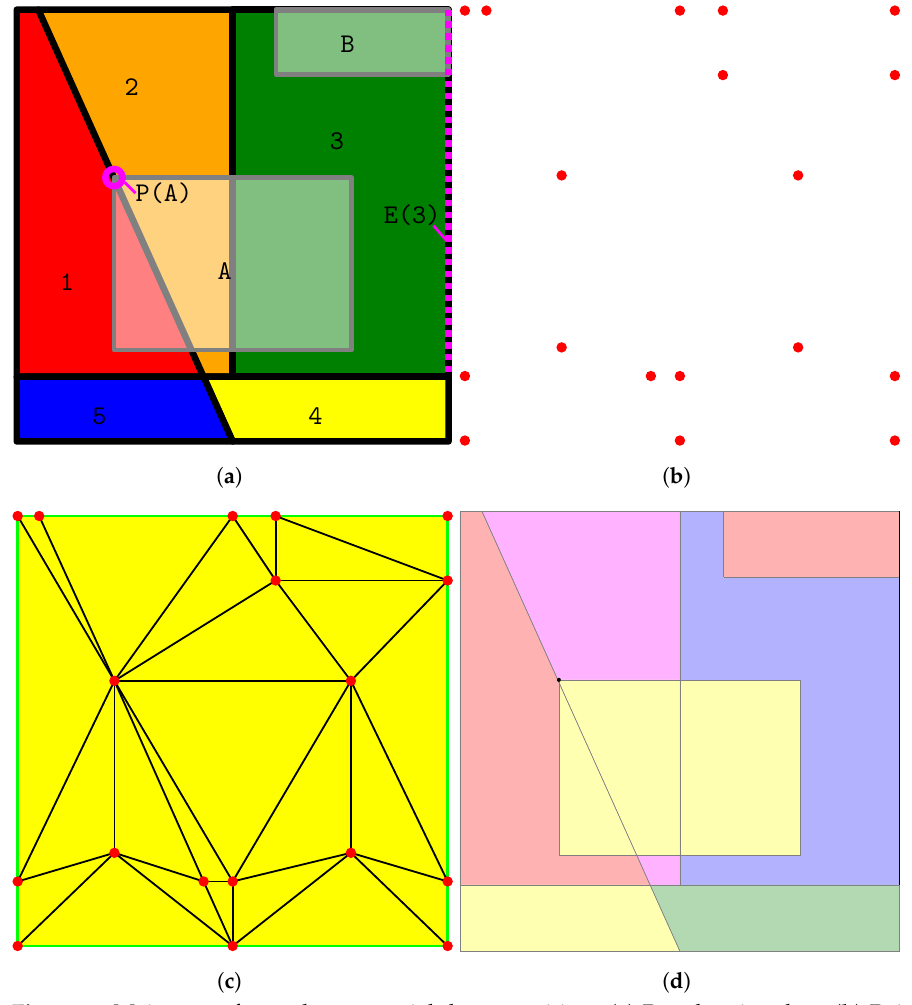
Figure 1. Main steps from plan to spatial decomposition. ( a ) Regular site plan. ( b ) Points of all features in the plan. ( c )Triangulation of all points. (base mesh) ( d ) Spatial decomposition of the